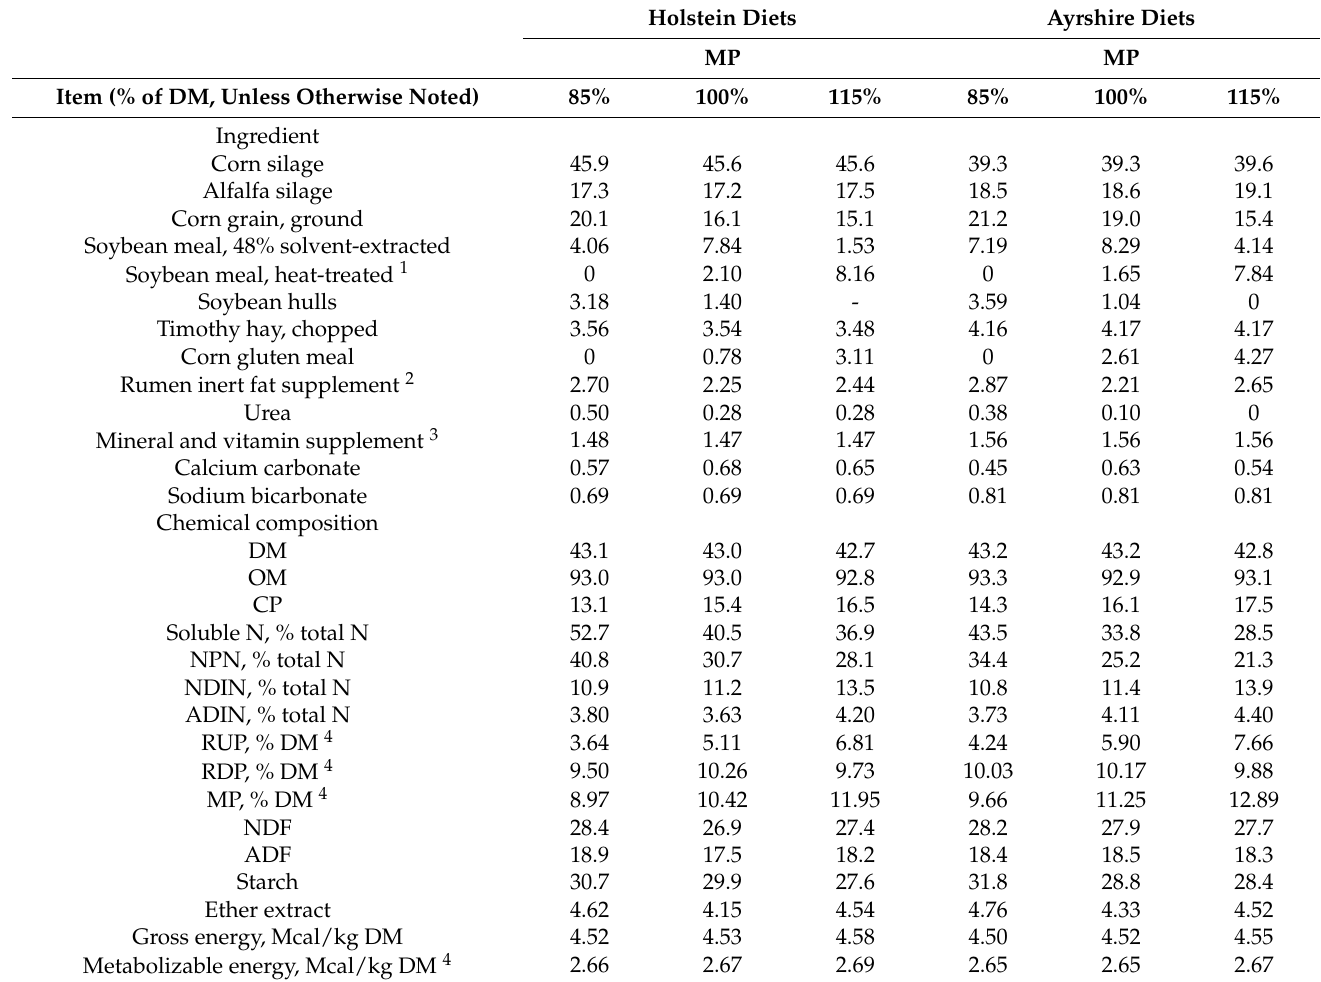
Table 1. Ingredient and chemical composition of the experimental diets formulated to provide 85%, 100%, or 115% of MP